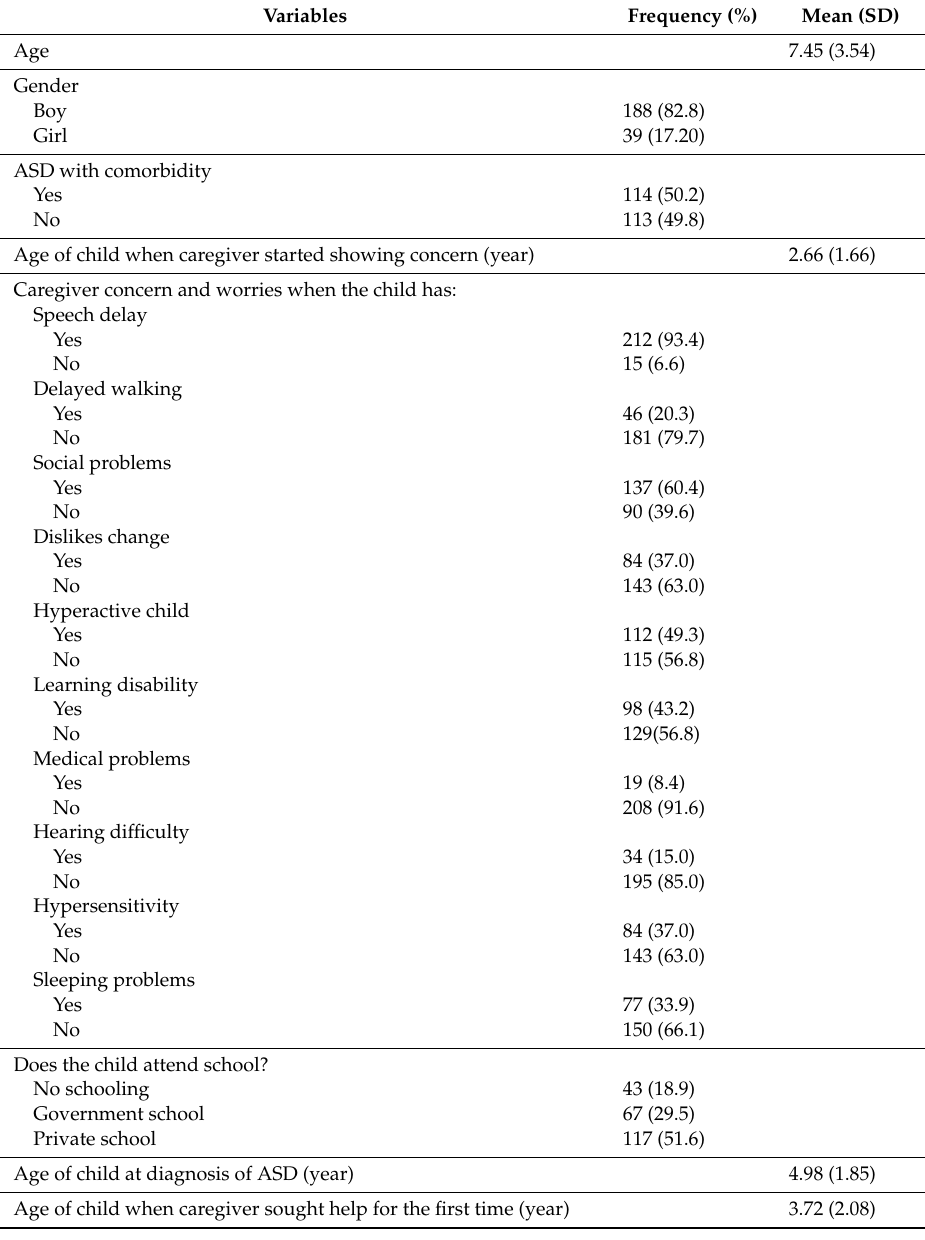
Table 2. Socio-demographic characteristics of the autism spectrum disorder (ASD) children ( n =